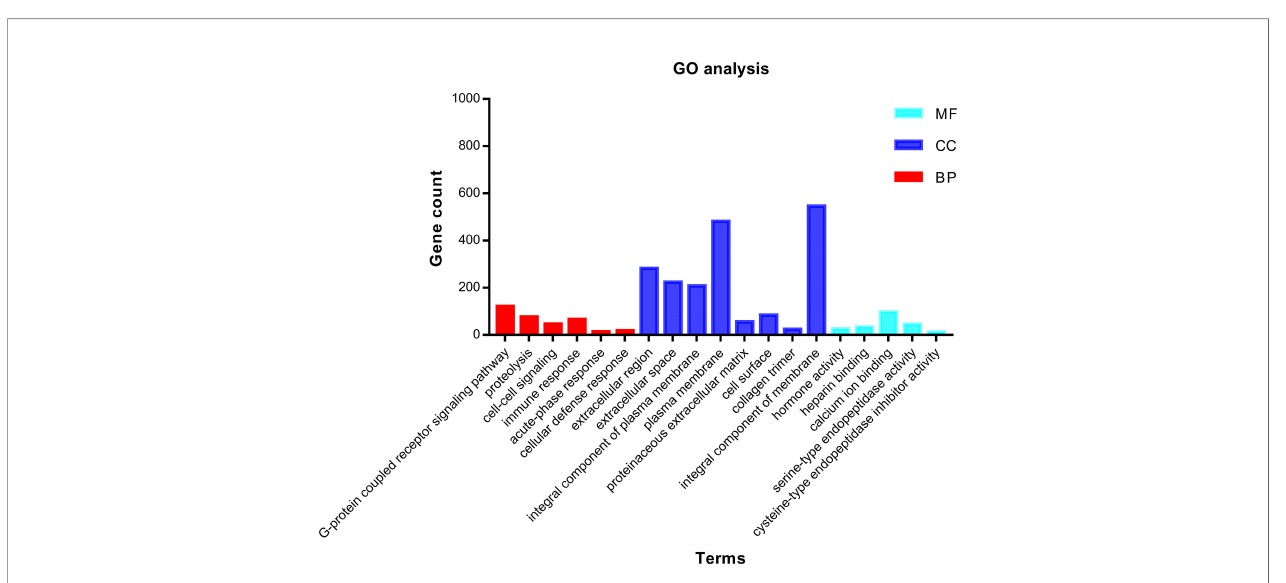
FIGURE 3 | GO functional enrichment analysis of 1,855 DEGs associated with ccRCC. Bright blue columns represent MF, navy blue columns represent CC, and red columns represent MF. GO, Gene Ontology; CC, cellular component; MF, molecular function; BP, biological process; DEGs, differentially expressed genes; ccRCC, clear cell renal cell